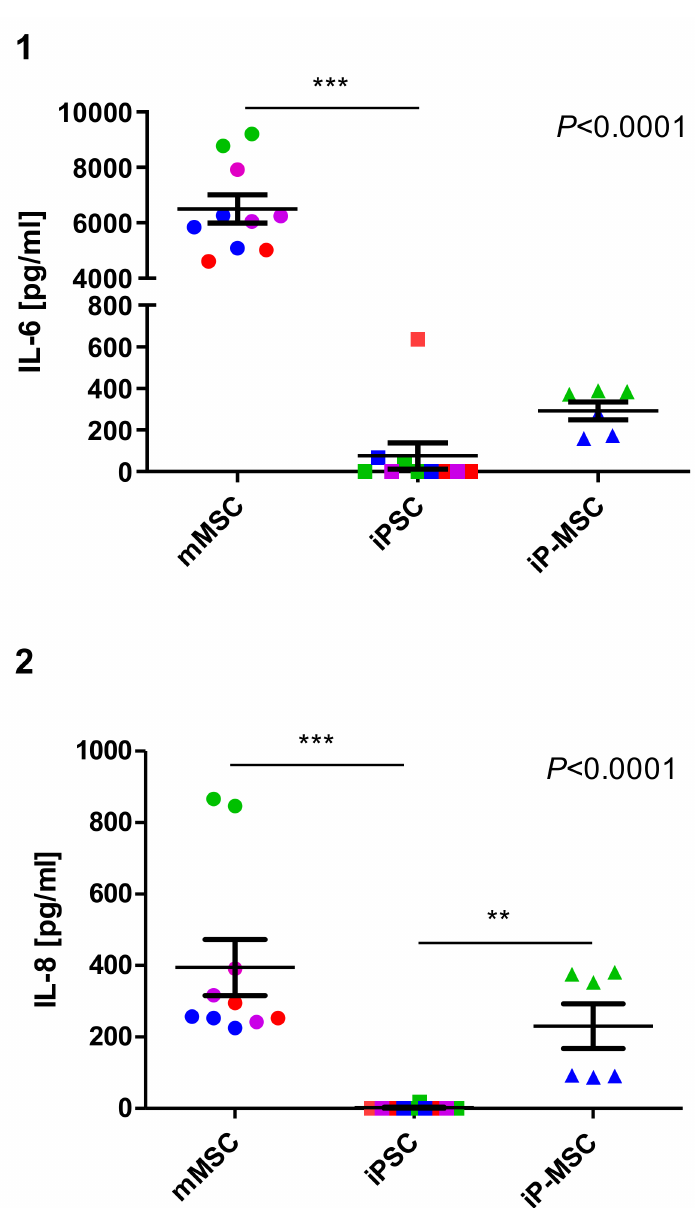
Figure 7. The cytokine profile of nasal mucosa mesenchymal stem cells (mMSCs) is partly restored in induced pluripotent stem-cell-derived mesenchymal stem cells (iP-MSCs) lines. The presence of ( 1 ) IL-6 and ( 2 ) IL-8 in the supernatant of MSCs, induced pluripotent stem cells (iPSCs), and iP-MSC after a culture of 24 h was measured by ELISA using cell lines of 4 different patients, which are indicated by color code. Means and standard error of the mean (SEM) are displayed in addition to individual data points. Differences between the cell types were analyzed by Kruskal–Wallis tests, and the respective p -values are displayed in the diagrams. Comparisons between individual lines were done by Dunn’s post hoc test, and significant differences are indicated (*** p < 0.001, ** p <